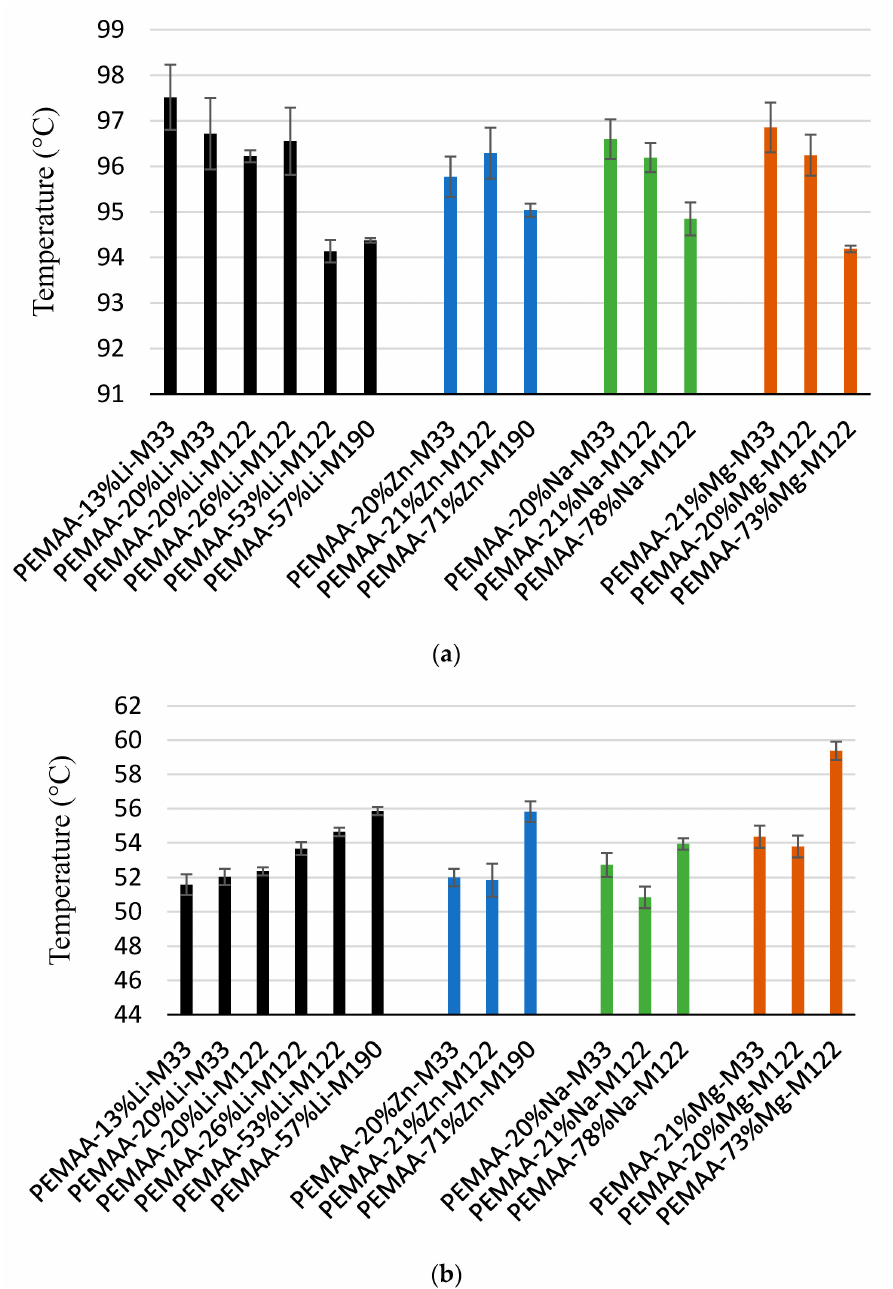
Figure 7. ( a ) Melting temperatures and ( b ) secondary crystallization temperatures of the PEMAA copolymers obtained from DSC